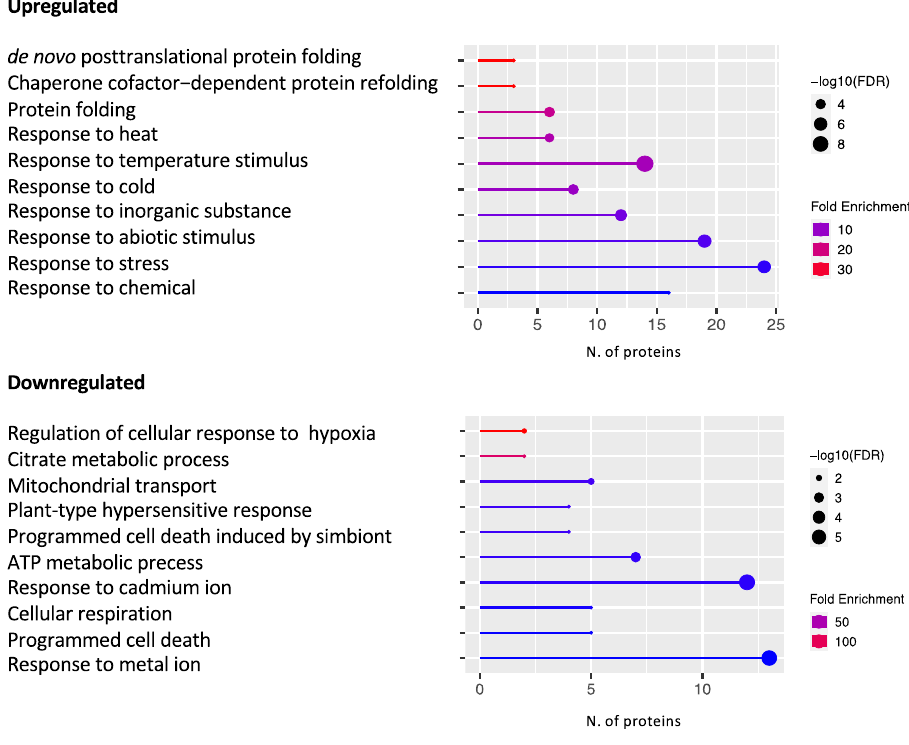
Figure 5. Graphical representation of the GO terms enriched in the S3 vs. S2 data set. The x -axis refers to the number of DEPs upregulated or downregulated that significantly enrich a specific GO term. Lines are colored by a red–blue gradient based on fold enrichment, whereas the size of the circle at the end of the lines is related to the statistical significance ( − log10 FDR).